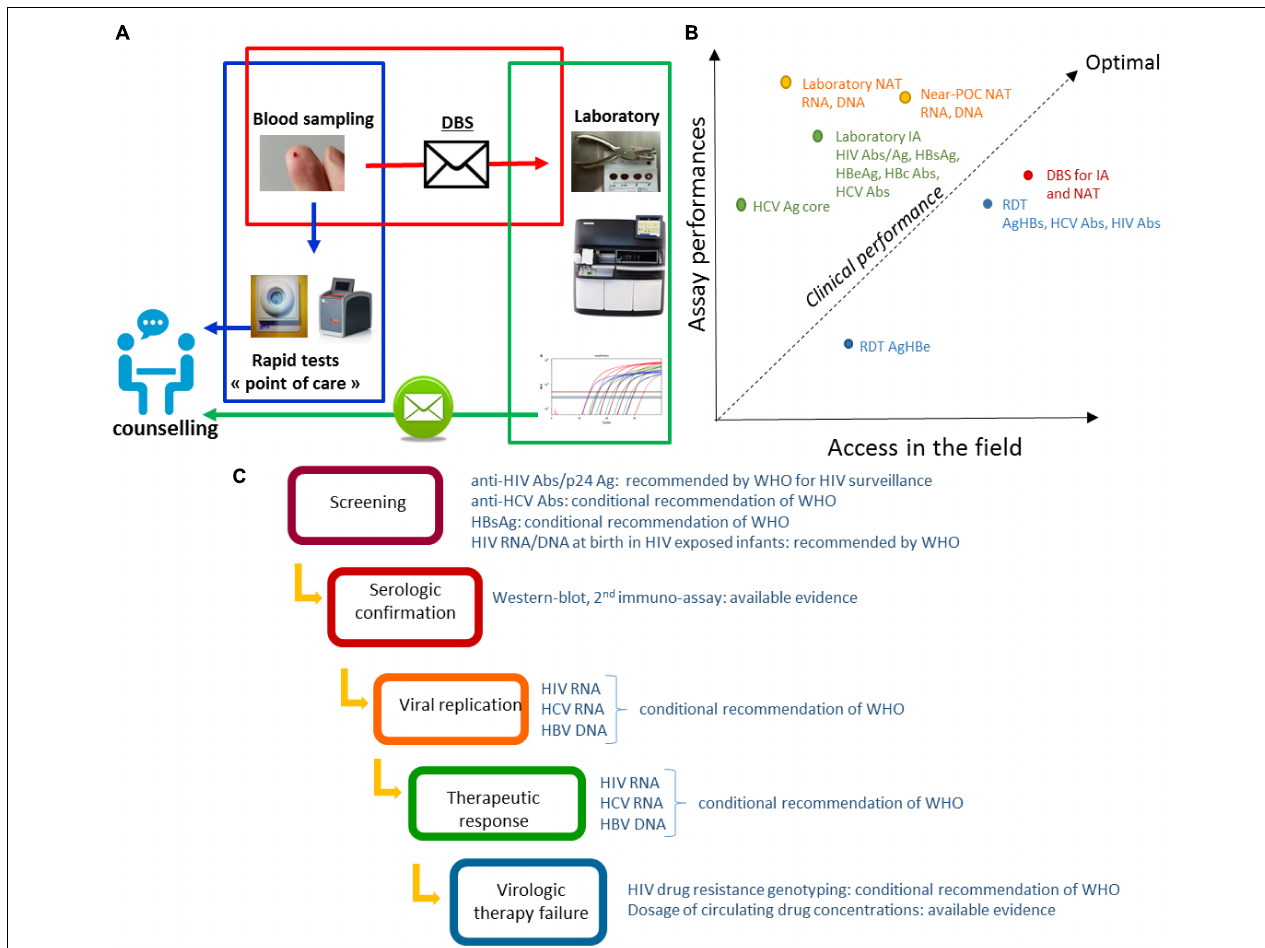
FIGURE 1 | (A) Possible organization of the diagnosis and management of infections combining rapid diagnostic tests and DBS. The sampling is carried out closer to the person detected or supported. Non-laboratory RDT are carried out in the peripheral structures in parallel with the sending of the DBS to the central laboratory carrying out complementary or confirmation analyses. Results are reported as part of the post-test counseling. (B) Clinical performance of in vitro assays dedicated to HBV, HCV, and HIV infections. The figure is a schematic representation of the clinical performances considered as a trade-off between assay performances and implementation coverage. Diagnosis and monitoring strategies based on different formats of tests have different clinical performances. Each format of test is characterized by its analytical performances mainly estimated by lower limit of detection (LOD), sensibility (Se) and specificity (Sp) based on previously published studies, and its global accessibility depending on parameters such as price, infrastructure requirements, distribution network, and acceptability as evaluated based on our own experience. The clinical performance in a population can be estimate by the proportion of infected persons tested and detected positive. Abs, antibodies; Ag, antigen; HIV Abs, anti-HIV antibodies; HCV Abs, anti-HCV antibodies; IA, immuno-assay; NAT, Nucleic acid tests; Near-POC NAT, Near point of care NAT; RDT, rapid diagnostic test. (C) DBS analyses during the therapeutic cascade for HIV, HBV, and HCV infections. The sampling on DBS allows the realization